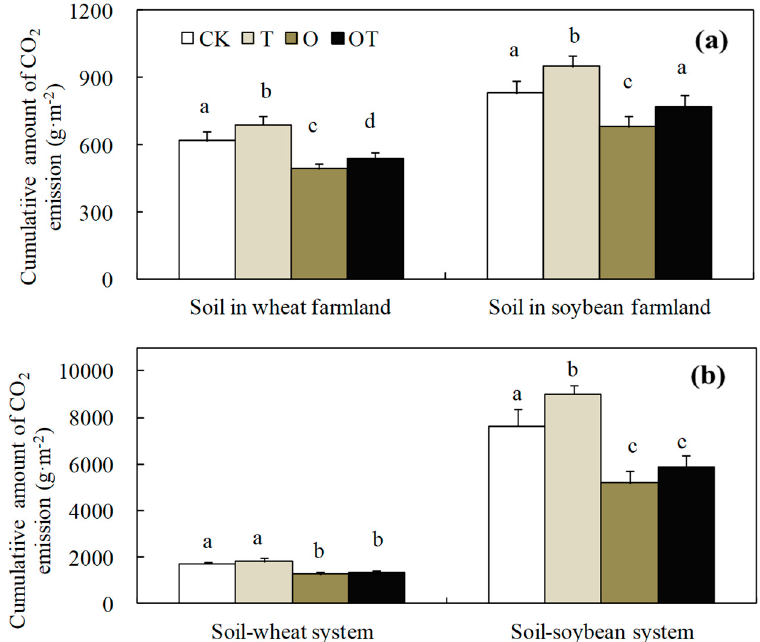
Figure 4. E ff ect of warming and elevated O 3 concentration on cumulative amount of CO 2 emission from soil and soil-crop system. Figure ( a ) and ( b ), cumulative amount of CO 2 emission from soil and soil-crop system, respectively. Data are the mean values. Error bars are SEs. Di ff erent lowercase letters denote significant di ff erence among di ff erent treatments at p ≤ 0.05.